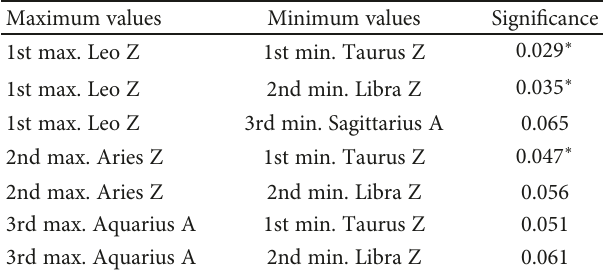
Table 1: Comparison of the three maximum values for complications under the zodiac signs and phase of the moon (Z=waxing, A =waning) to the three minimum values for complications, with reference to the zodiac sign and the phase of the moon. ∗ Statistically signi fi cant in Pearson ’ s chi-square